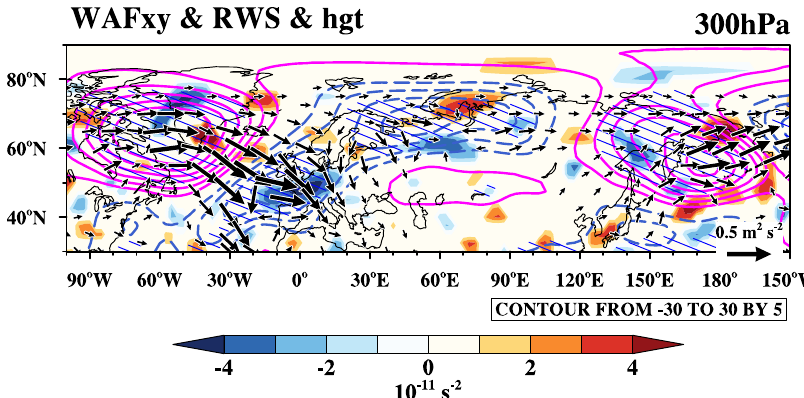
Fig. 5 Winter BK sea ice-related spring Eurasian atmospheric pattern. Spring RWS (10 − 11 s − 2 , shading) and geopotential height anomalies (m, contour) at 300-hPa regressed onto the negative winter BK sea ice index and the related horizontal WAF (m 2 s − 2 , vector). WAF values lower than 0.05 m 2 s − 2 are not plotted. Contour interval is 5 m. Blue and pink contours indicate the negative and positive geopotential height anomalies. The RWS anomalies signi fi cant at the 90% con fi dence level are plotted. Hatched areas denote geopotential height anomalies signi fi cant at the 90% con fi dence level.